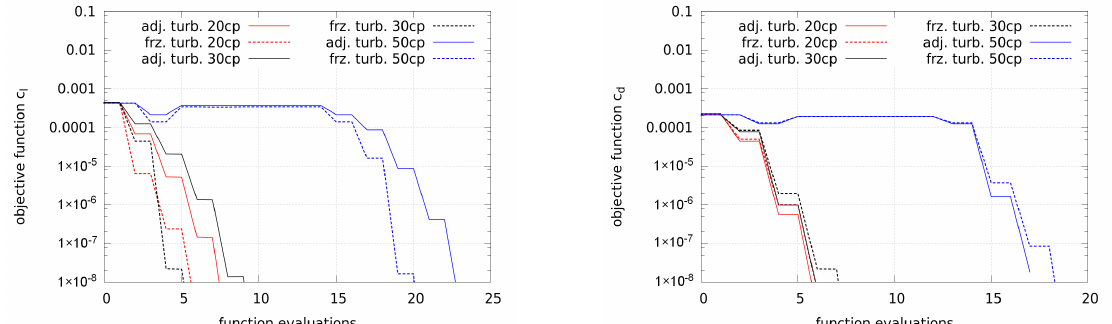
Figure 16. Objective functions for lift and drag as in Equation (14) along the number of function evaluations for the DU 93-W-210 at AoA = 6 ◦ . Frozen as well as adjoint turbulence are used. The number of control points is labeled as